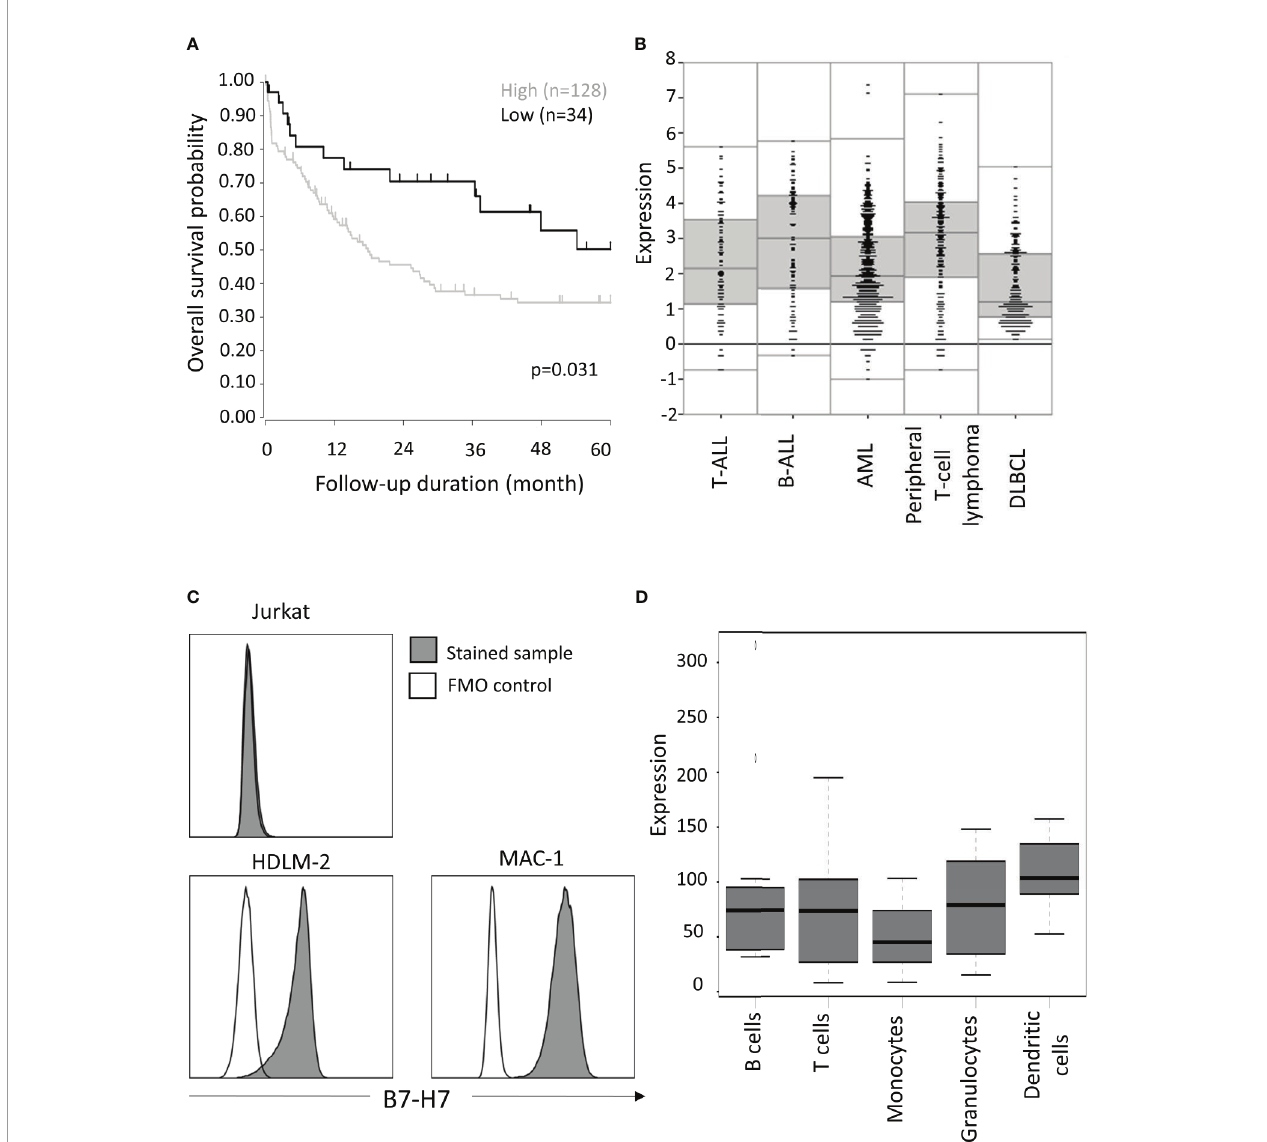
FIGURE 1 | Expression of HHLA2/ B7-H7 in T cells. (A) Overall survival outcome of T-cell peripheral lymphoma patients with high (expression value ≥ 3) versus low (expression value<3) expression level of B7-H7. Of the 193 patients, only 162 provided survival data, for which overall survival probability over fi ve years is calculated, using the log-rank test. (B) B7-H7 RNA expression analysis according to R2 data visualization platform for DLBCL (GEO: gse87371), B-ALL (GEO: gse7440), AML (GEO: gse14468) T-ALL (GEO: gse10609) and T-cell peripheral lymphoma patients (GEO: gse58445). (C) B7-H7 expression on different cell lines with T cells origin: Jurkat, HDLM-2 and MAC-1.